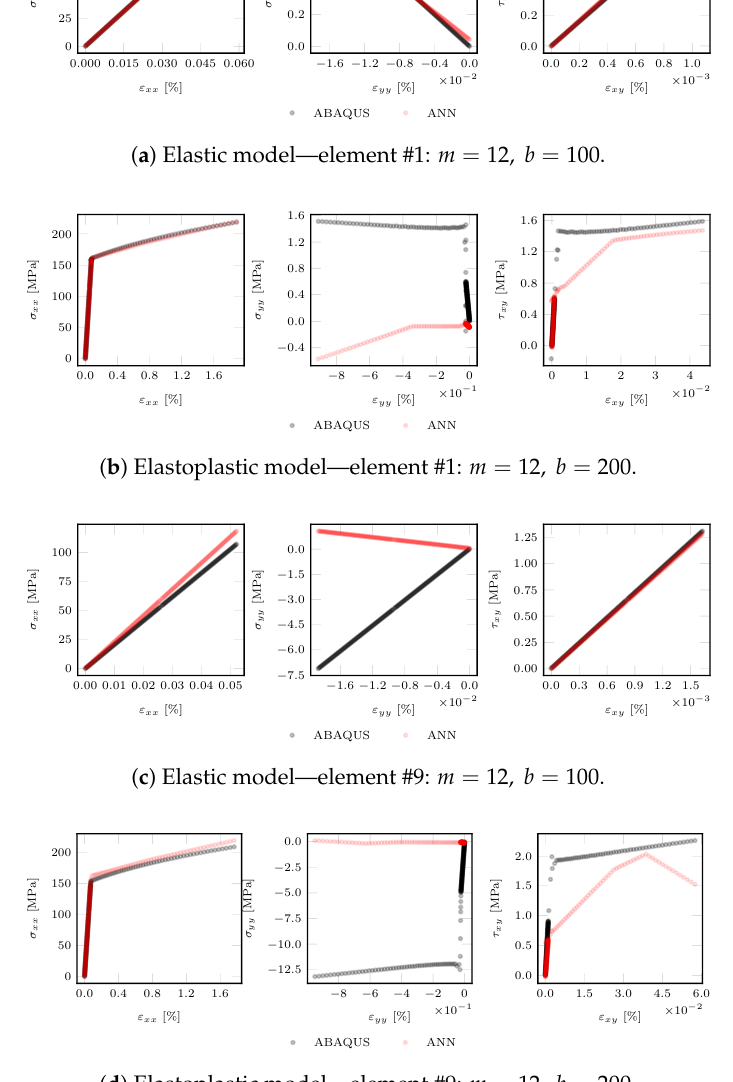
( d ) Elastoplastic model—element #9: m = 12, b = 200. Figure 22. Stress-strain curves corresponding to the elements 1 and 9 for the ANN-based elastic and elastoplastic response